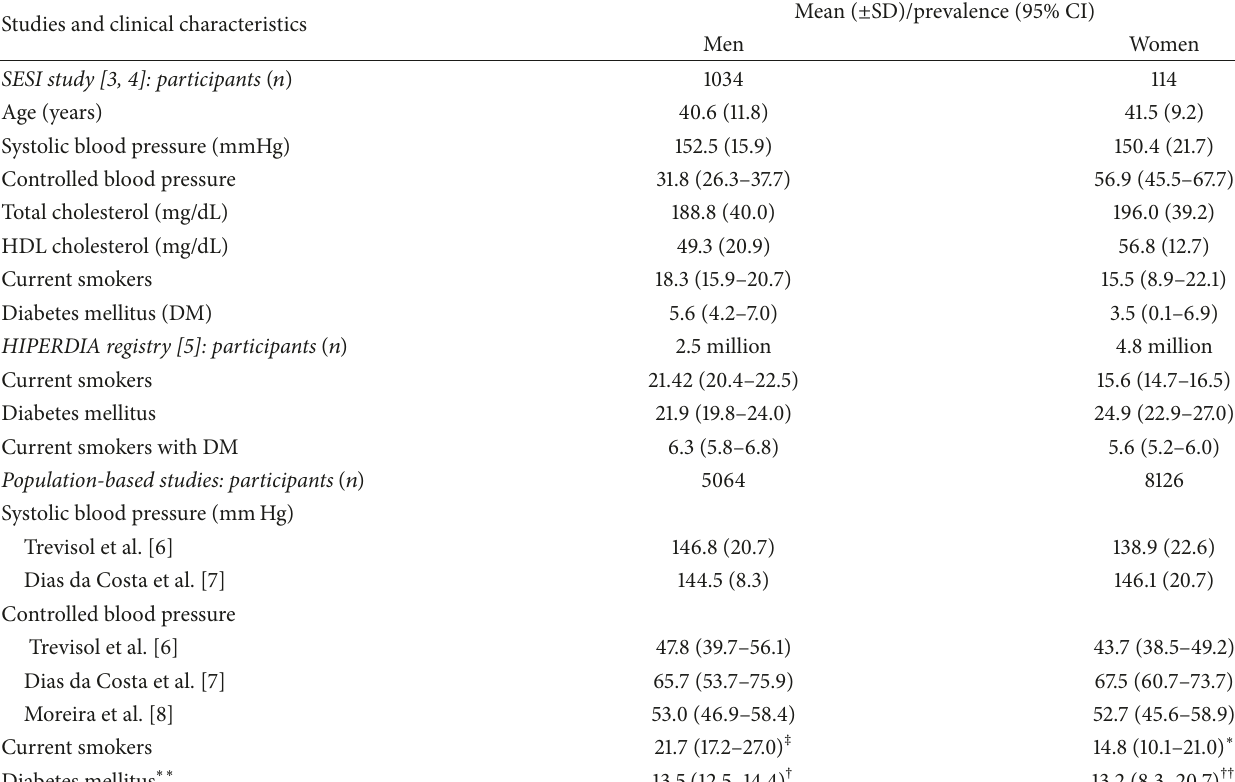
Table 1: Clinical characteristics of individuals with hypertension from the SESI study, the HIPERDIA registry, and from meta-analyses of four population-based